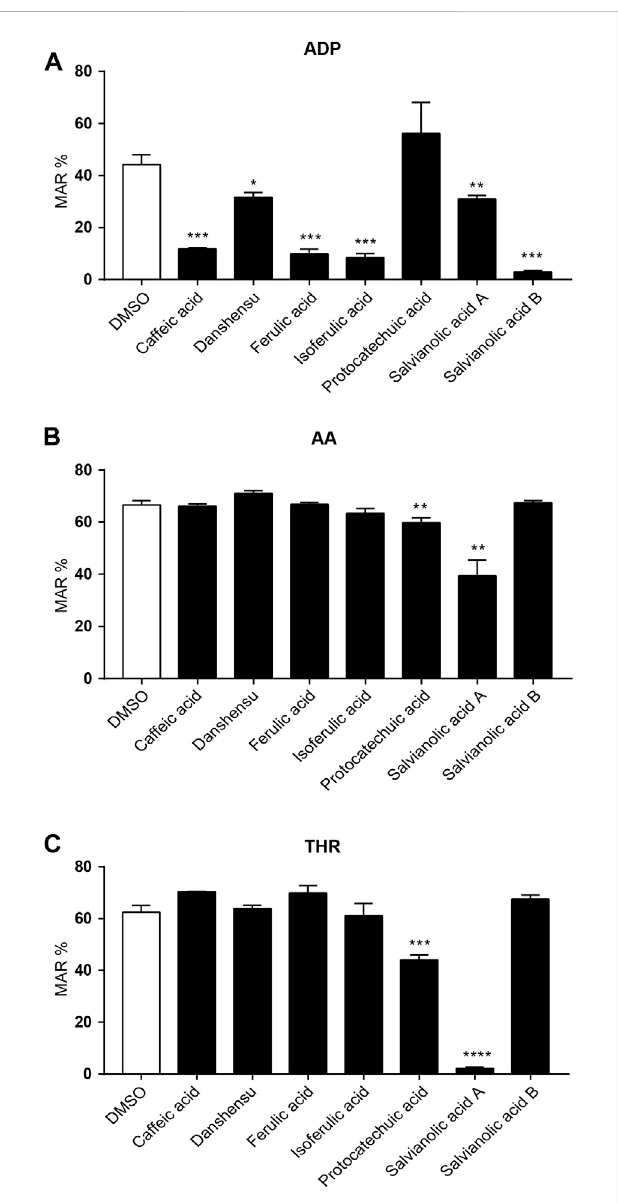
FIGURE 4 Effect of phenolic acids on ADP, AA, THR-induced platelet aggregation in vitro . Platelet aggregation was induced by adenosine diphosphate (ADP: 5 × 10 – 6 mol/L, (A) , arachidonic acid (AA: 5 × 10 – 3 mol/L, (B) and thrombin (THR:750 U/L, (C) , respectively. n = 3, mean ± SEM. * p < 0.05, ** p < 0.01, *** p < 0.001 and **** p < 0.0001 vs. DMSO